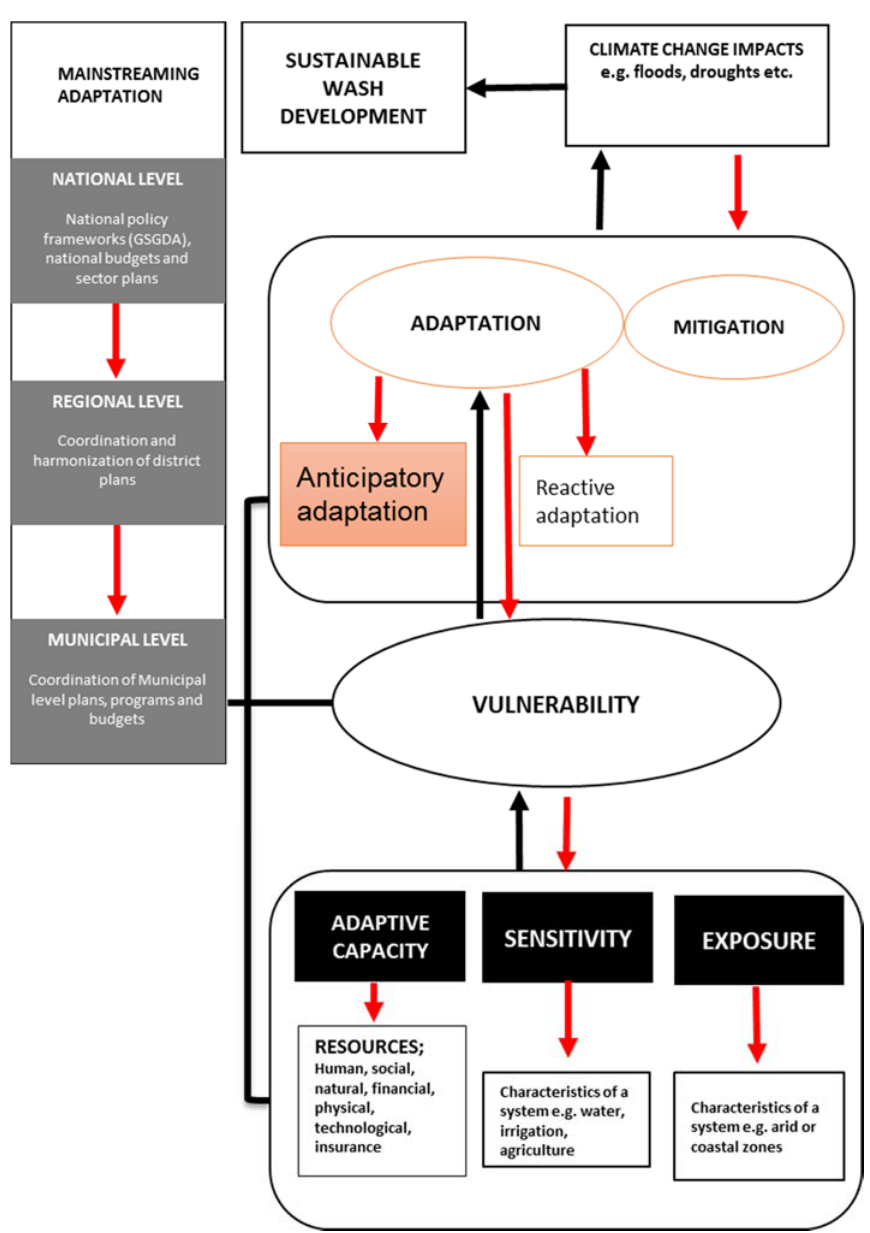
Figure 3. A conceptual model for mainstreaming climate change adaptation measures into development planning at all levels of government. The red arrows show the normal processes of adaptation, while the black arrows show feedback loops. Source: Authors construct, (2016). GSGDA is the Ghana Shared Growth Development Agenda.